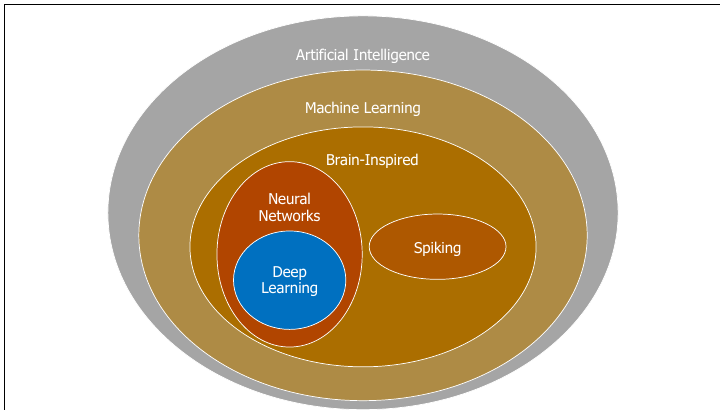
Figure 1. Relationship between deep learning and the rest of